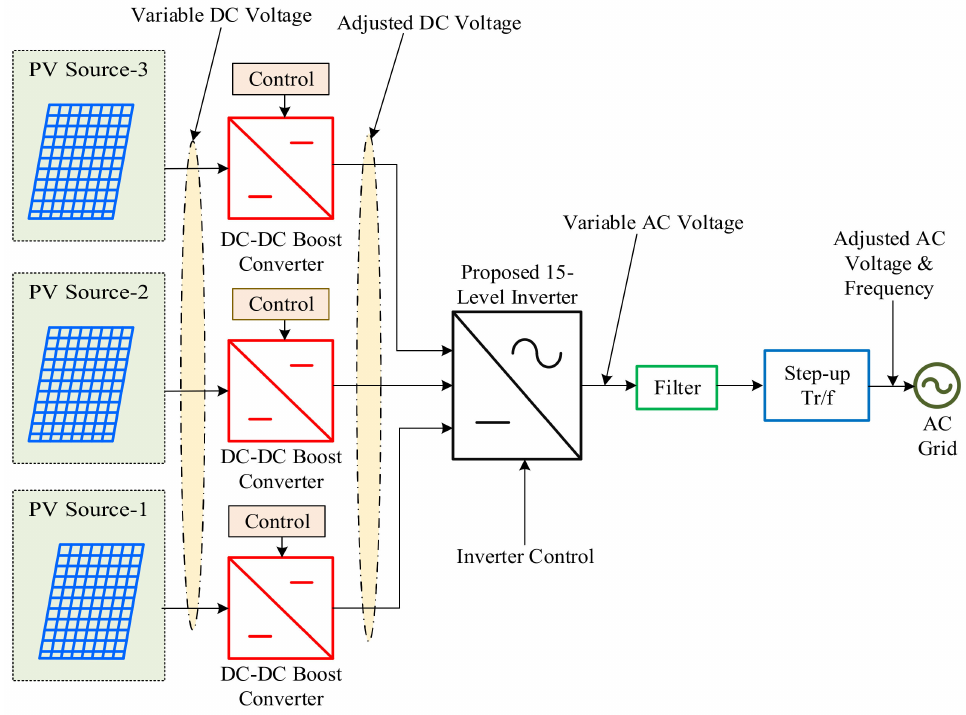
Figure 3. Schematic diagram of proposed grid-connected SPV